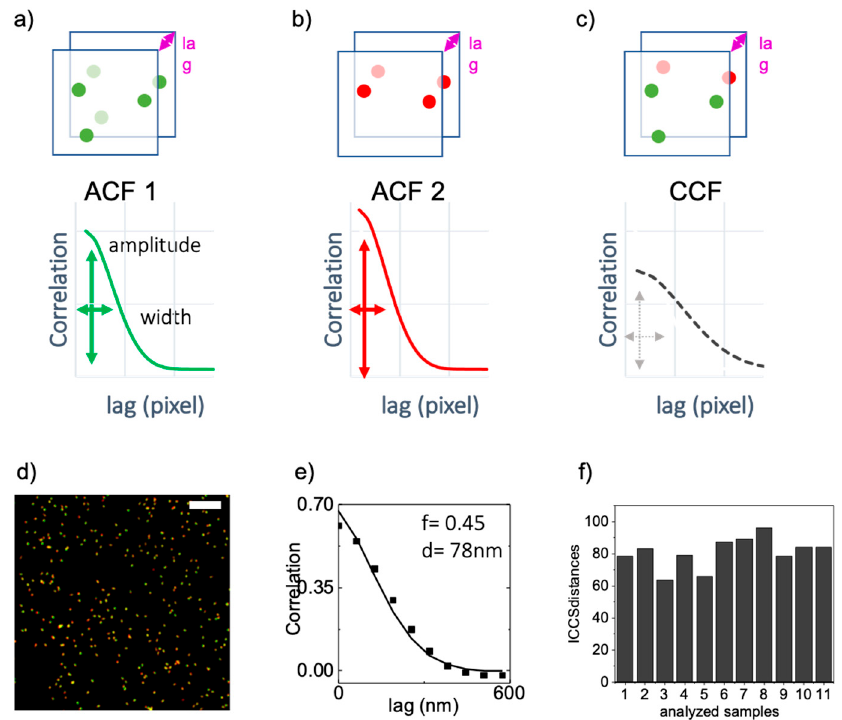
Figure 4. Image Cross-Correlation Spectroscopy (ICCS) analysis of optical nanorulers. ( a – c ) Schematic representation of the ICCS analysis. The amplitude and width of the Cross-Correlation Function (CCF) ( c ) are compared with the amplitude and width of the Auto Correlation Functions (ACF) of the single channel images ( a , b ) to extract a value of colocalization fraction and a value of correlation distance. ( d , e ) SIM reconstructed super-resolution image (512 × 512 pixel ROI) and corresponding image cross-correlation function. The colocalization fraction value ( f ) and average correlation distance ( d ) are indicated. Scalebar 5 µ m. ( f ) Plot of ICCS distance values found in the 11 samples analyzed, from which we calculated the average distance d = 80 ± 9 nm (Mean ± SD).